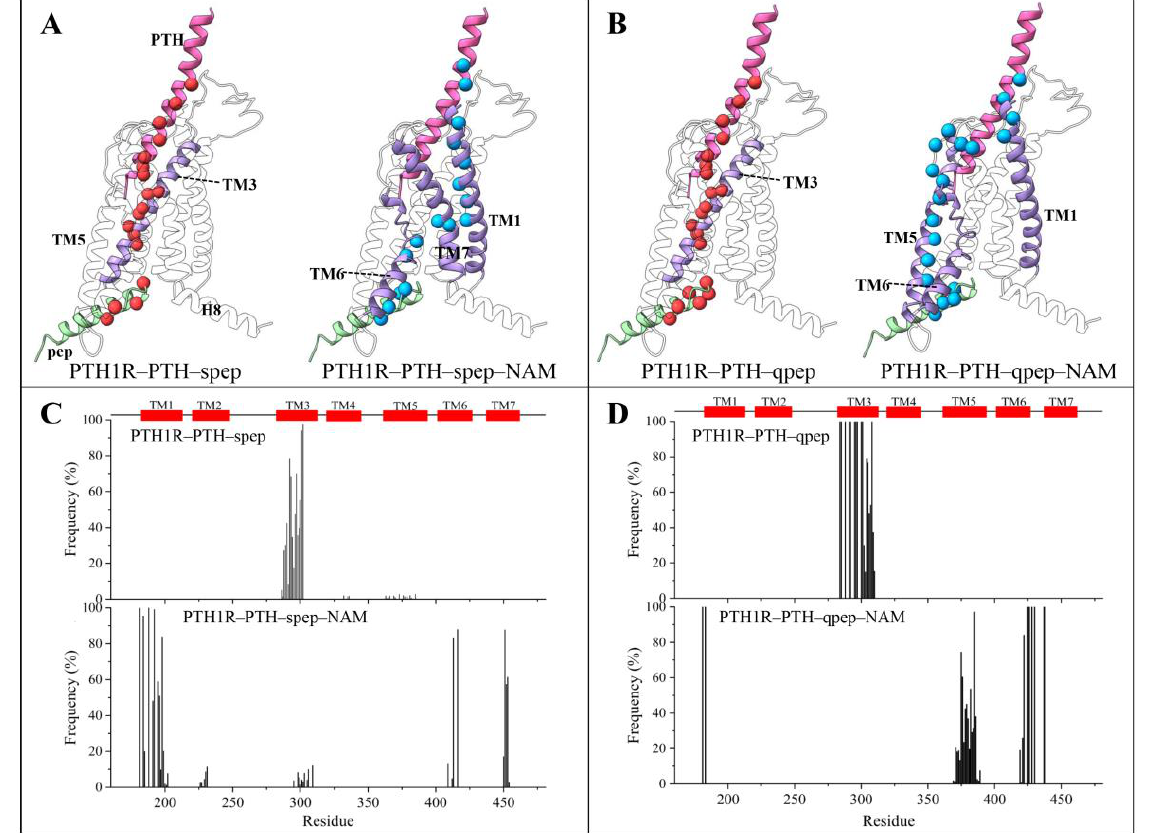
Figure 8. Allosteric signal propagating paths from the PTH to peps. ( A , B ) Optimal paths of each system are colored red and blue, respectively. ( C , D ) The frequencies of residues involved in all recognized pathways are displayed on the structures.